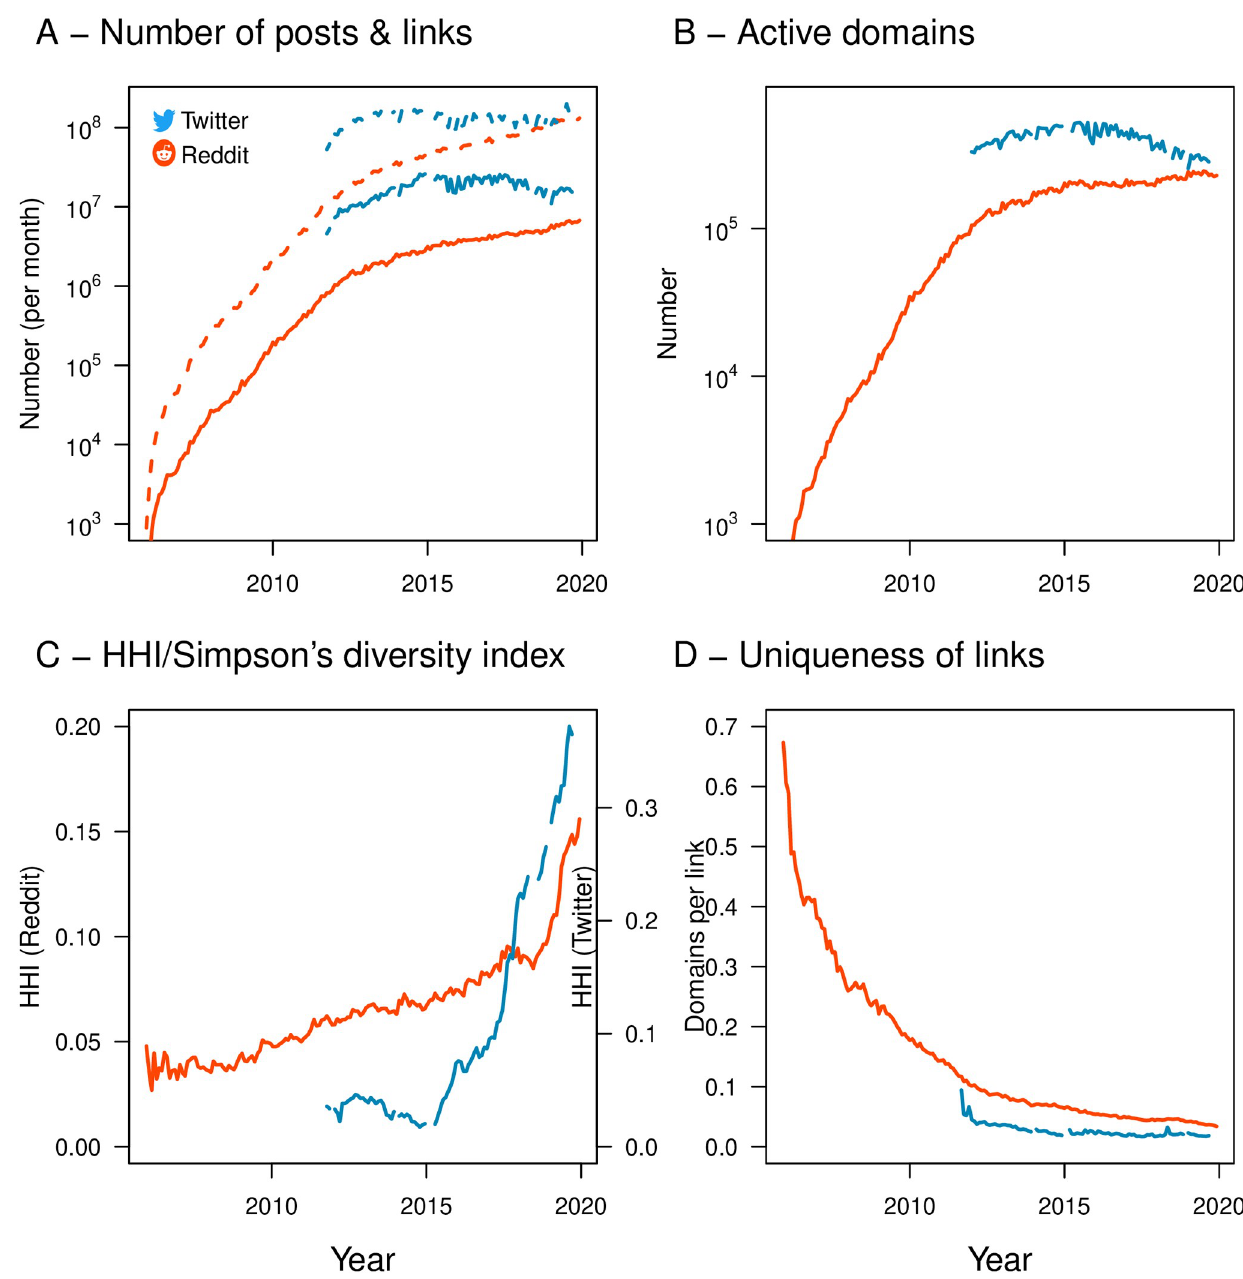
Fig 1. Dynamics of activity on online platforms, as indicated via posts in social media platforms. (A) Growth in the number of posts (dotted) and links within posts (solid) in both Reddit and Twitter over time. (B) The number of distinct active domains appearing within social-media links to has also grown. (C-D) An increase the HHI index (C) and a decrease in link originality (D) for domains within links indicates that, despite the growth in total activity (A-B) diversity in online activity is in long term decline (see Sec. Materials and methods).